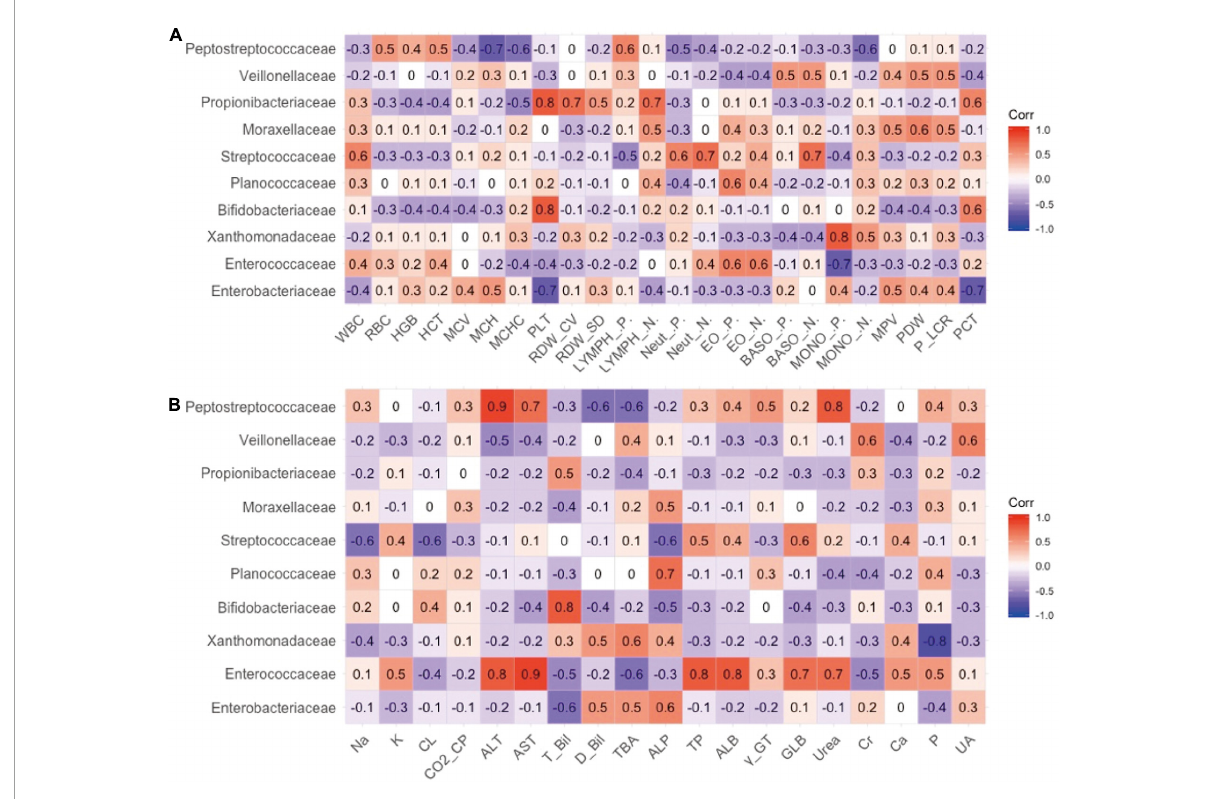
FIGURE3 The relevance between the family level of intestinal flora and secondary clinical outcomes. (A) The Pearson correlation coefficient of the family level of intestinal flora and blood routine indicators. (B) The Pearson correlation coefficient of the family level of intestinal flora and blood biochemistry